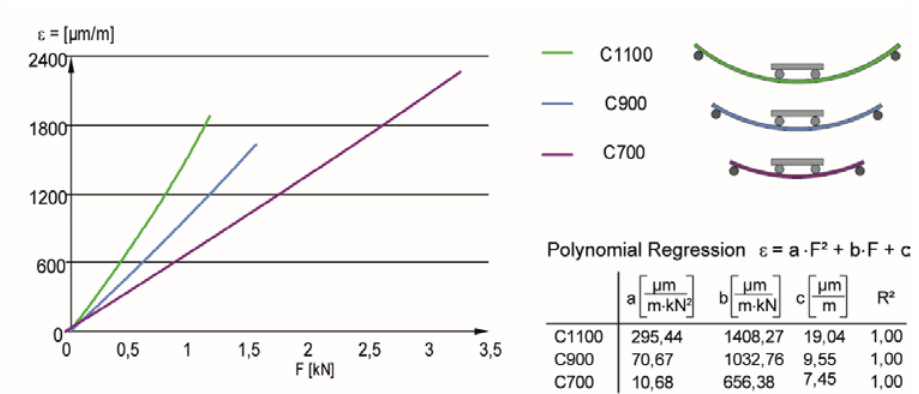
Fig. 7 Results of the strain measurement in the centre of the specimens (strain gauge 2, see Fig. 3). With varying spans and determined parameters of polynomial